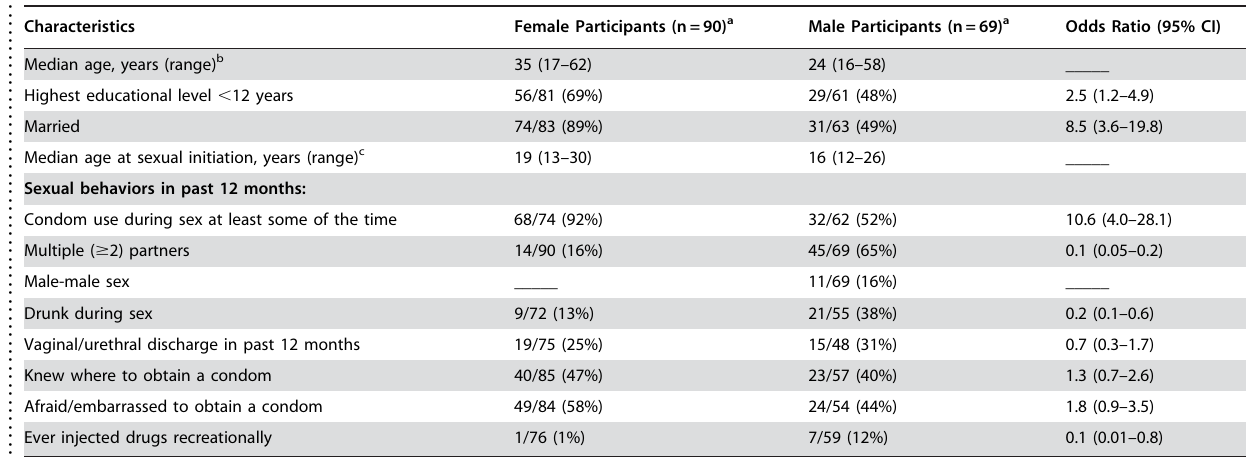
Table 1. Characteristics of Male and Female Survey Participants Who Were Sexually Active in the 12 Months before an